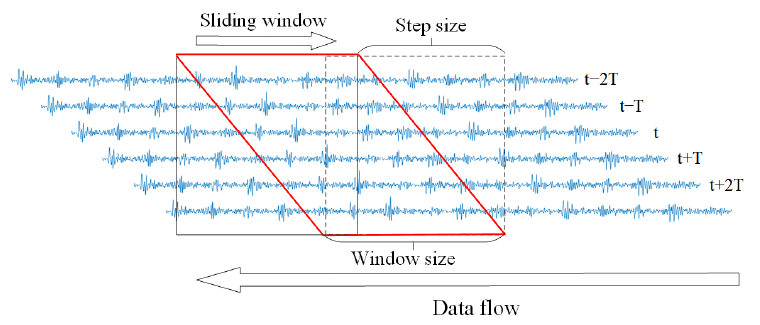
Figure 11. Schematic diagram of the repeated calculation part of the real-time data flow.